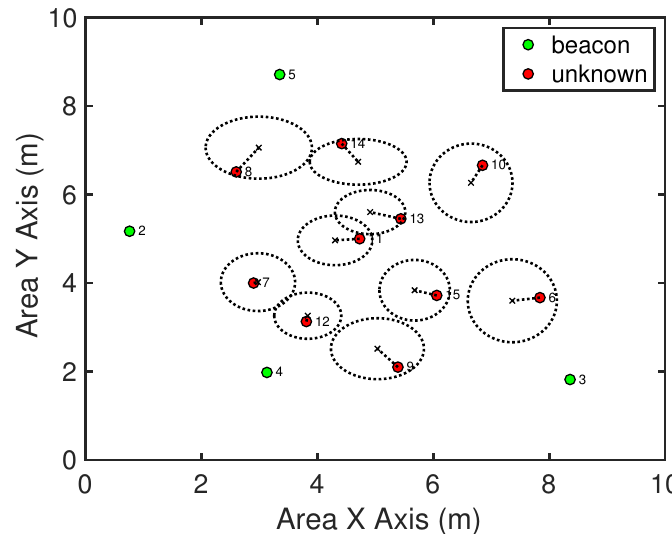
Figure 16. The position estimate and the estimated uncertainty on each unknown node at the end of the experiment for one random generated topology described in Section 5.2.2 when using KK algorithm under RSSI measurements. The ground-truth position of the unknowns are represented by red dots, and current position estimates are represented by black crosses. The estimated uncertainty of each unknown is represented by an ellipse (circles when using KI), and the semi-axes of the ellipse are 3 σ of the estimated uncertainty distribution (modeled as Gaussian), in x and y directions.